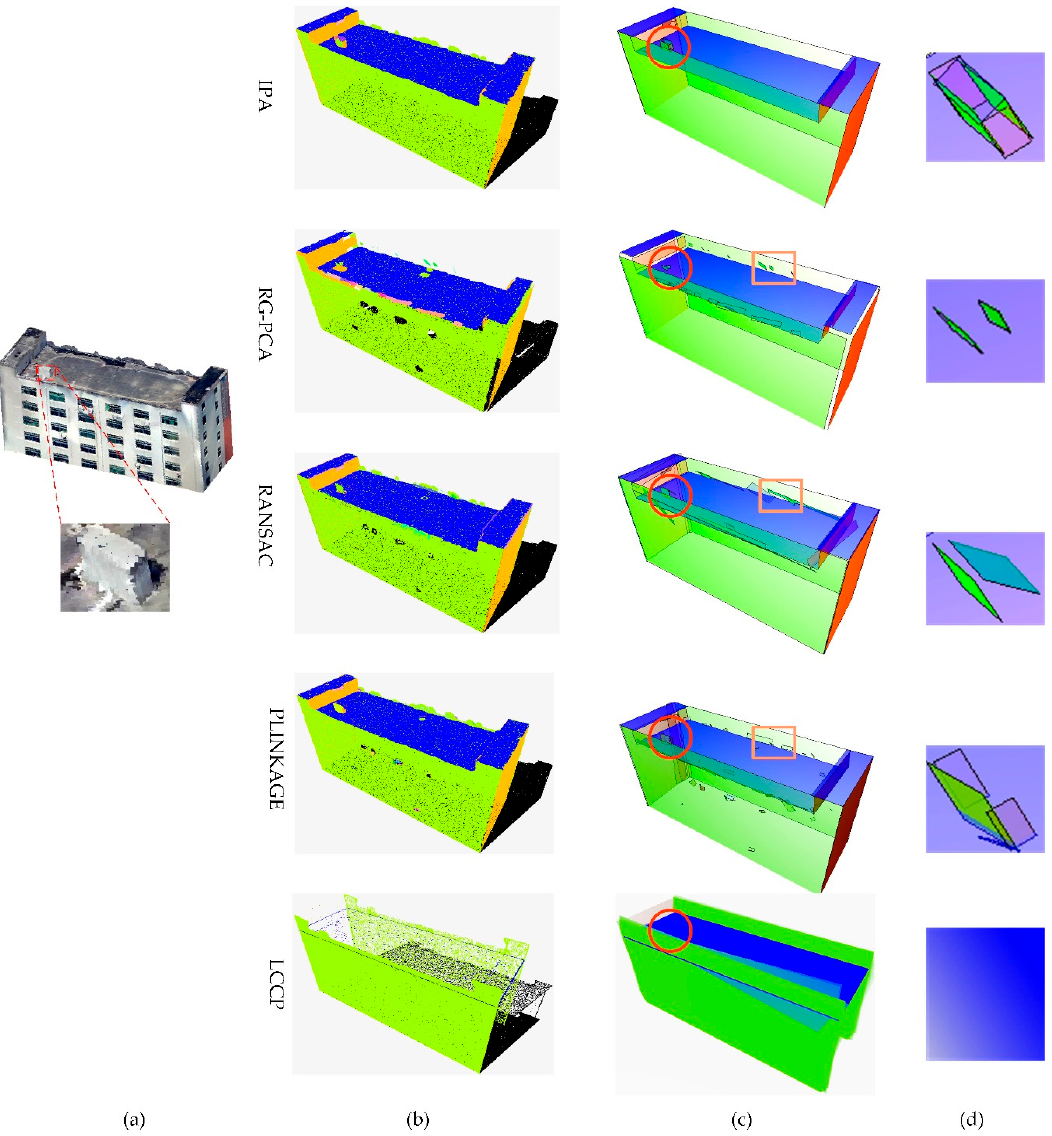
Figure 12. Comparison of the planar abstraction quality of building 2. ( a ) Building point cloud, ( b ) planar abstractions, ( c ) extracted planes approximated by a set of planar polygons, and ( d ) magnified images of the circle marked regions in ( c ).